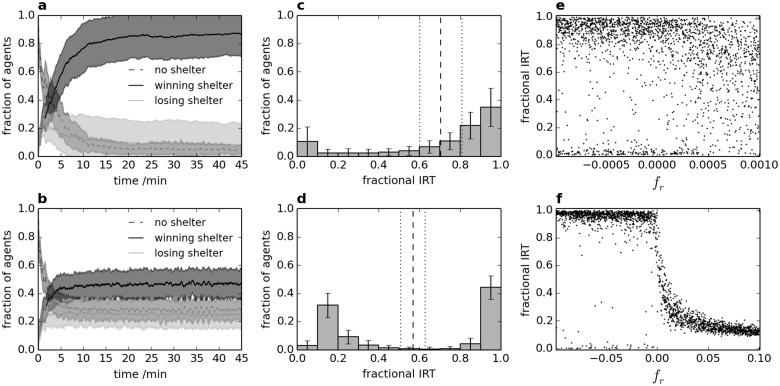
Effect of personality on aggregation and IRT for small and large ranges of randomly distributed fr values.(a)-(b) Aggregation dynamics for agents with fr values between ±0.001 and ±0.1 respectively; (c)-(d) corresponding distributions of IRT; (e)-(f) corresponding fractional IRT versus fr, where each dot represents the fractional IRT of a single agent.